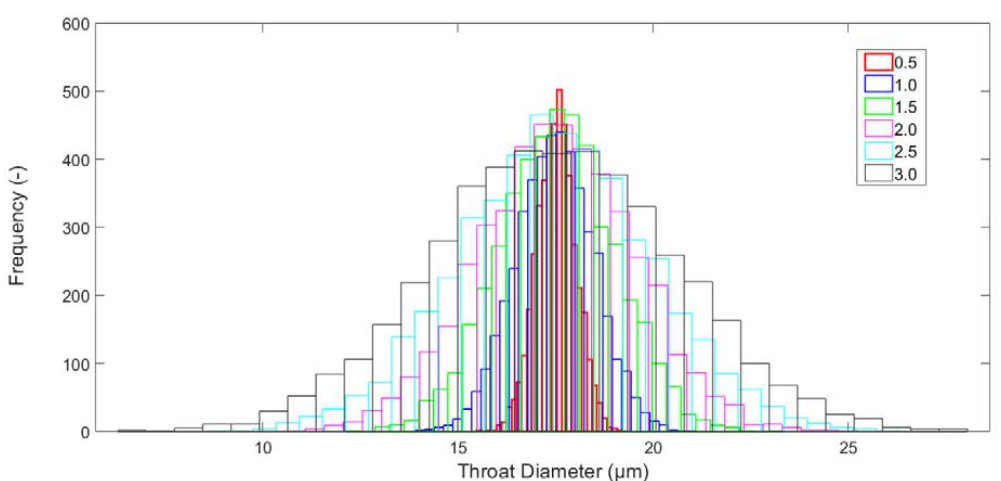
Figure 9. Histograms of pore size distribution (PSD) with varying standard deviation in µ m as indicated in the legend.